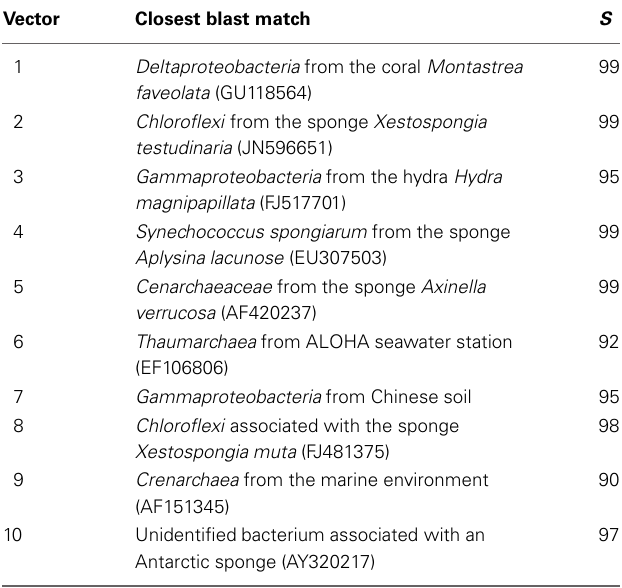
Table 2 | Microbial sequences detected by DGGE that discriminate between sponge hosts (correlation >